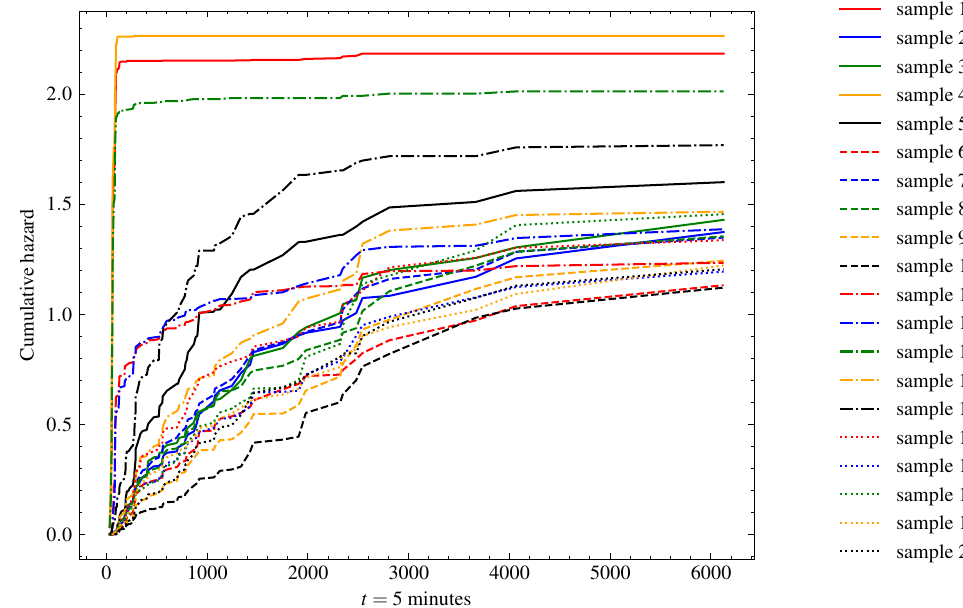
Figure 7. Cumulative hazard function estimate of test samples ( n = 20) using TSF-RSF. The cumulative hazard risk increased as the operation time increased, with the highest rate occurring in the first 3000 5 min time units of operation. In unstable start-up operating cycles, this increase happened drastically in the first moments of